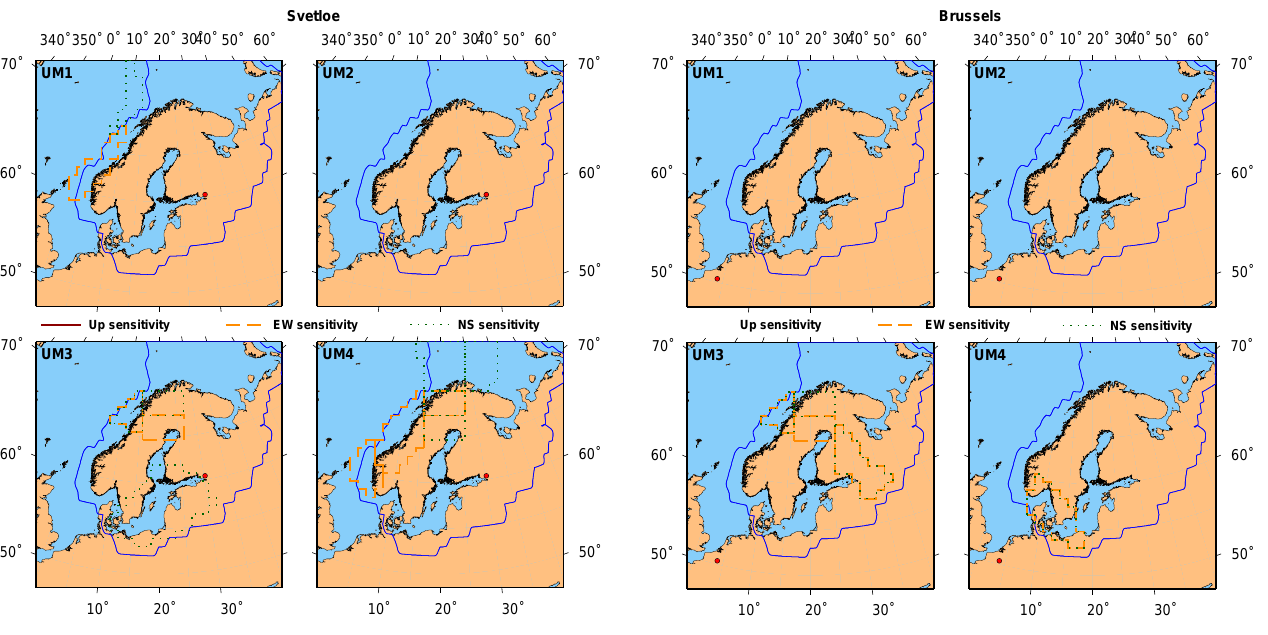
Fig.11. SameasFig.4,butforSvetloe. Figure 11. Same as Fig. 4, but for Svetloe.